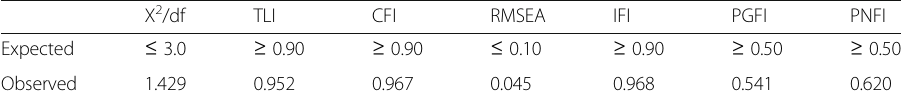
Table 6 Fit statistics of the measurement model X 2 /df TLI CFI RMSEA IFI PGFI PNFI Expected ≤ 3.0 ≥ 0.90 ≥ 0.90 ≤ 0.10 ≥ 0.90 ≥ 0.50 ≥ 0.50 Observed 1.429 0.952 0.967 0.045 0.968 0.541